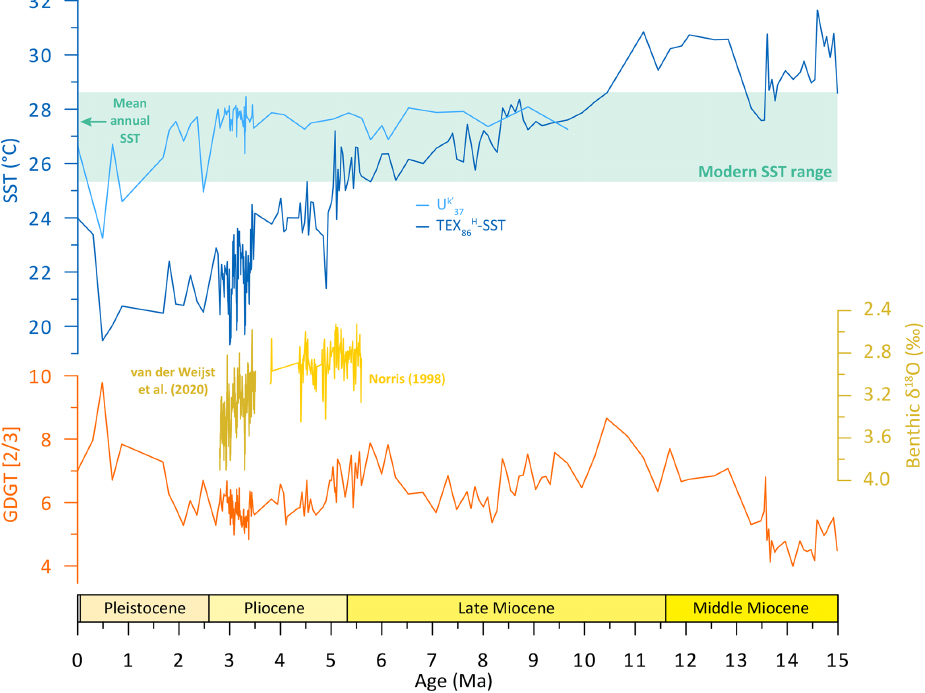
-SST (Kim et al., 2010 calibration), U k (cid:48) -SST (Müller et al., 1998 calibration) and GDGT [ 2 / 3 ] records at Site 959, Figure 3. New TEX H 86 37 compared to benthic δ 18 O records from Norris (1998a) and van der Weijst et al. (2020). Shaded interval and arrow indicate annual SST range and mean annual SST in the Gulf of Guinea, respectively (Locarnini et al., 2013).